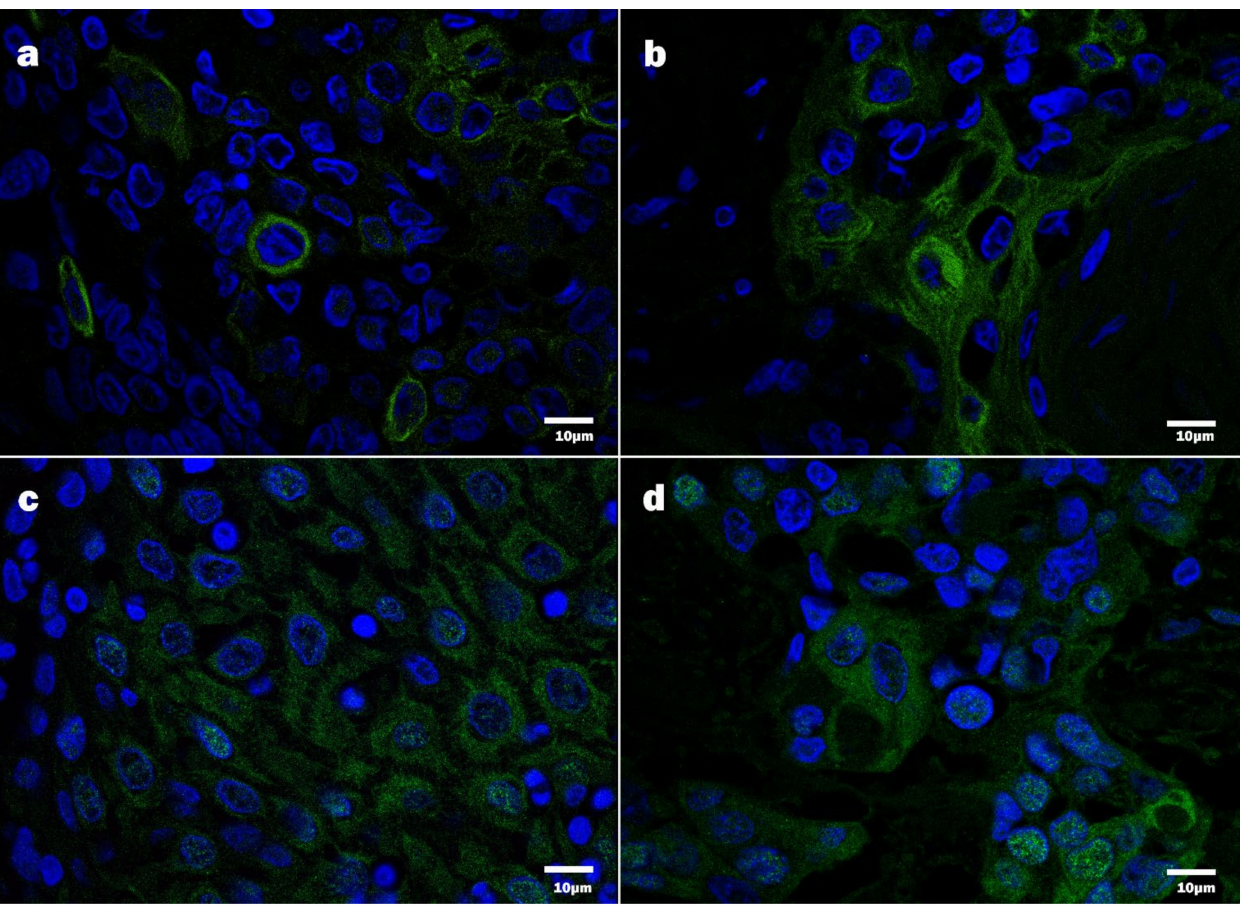
Figure 5. Detection of HPV16 protein E7 by immunofluorescence, confocal microscopy, DAPI—blue, HPV16 E7 immunopos- itive products—green: ( a , b ) HPV16 E7 positive tumor cells, displaying chiefly cytoplasmic positivity; ( c , d ) HPV16 E7 positive tumor cells, displaying cytoplasmic and nuclear